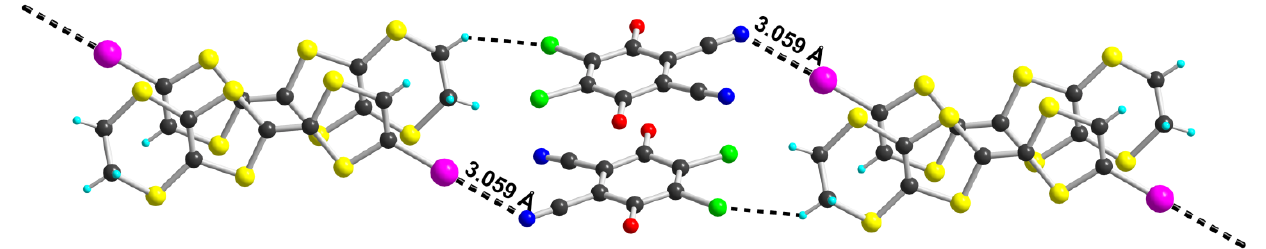
Figure 3. Detail of the halogen bonding interactions in ( 1 )(DDQ).